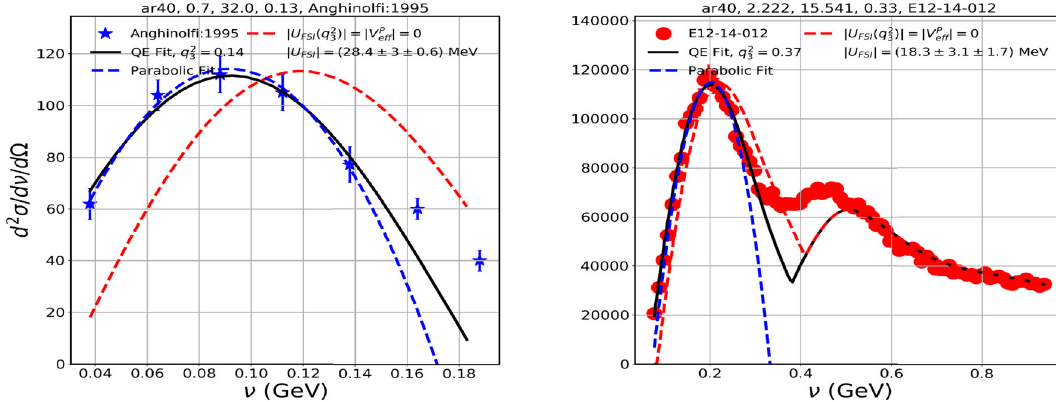
= 0 . 251 GeV) QE differential cross Ar ( k P F 18